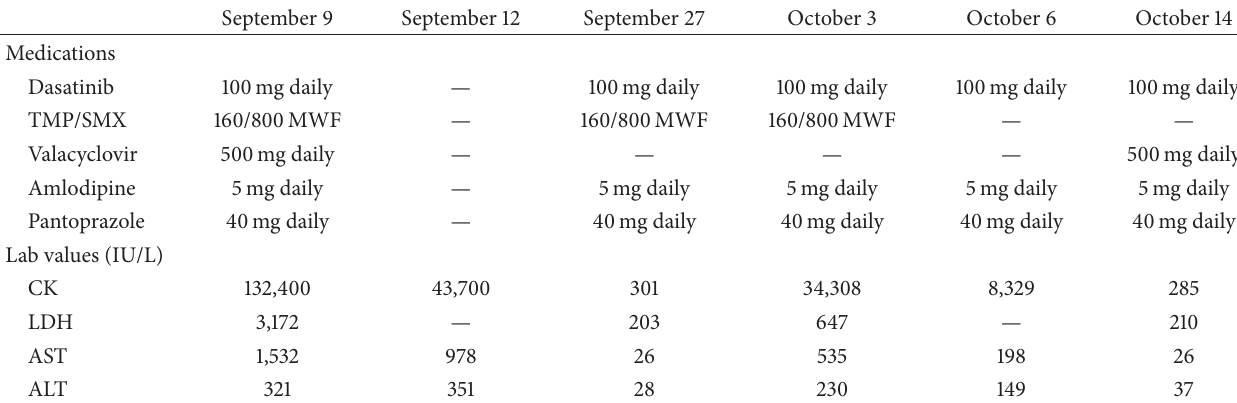
Table 1: Complete medication and dosing history with relevant laboratory values for our patient during first inpatient admission for rhabdomyolysis (September 9, 2013), discharge (September 12, 2013), and outpatient clinic follow-up visit (September 27, 2013). The same information is also presented for the second inpatient admission for rhabdomyolysis (October 3, 2013), discharge (October 6, 2013), and outpatient clinic follow-up visit (October 14,